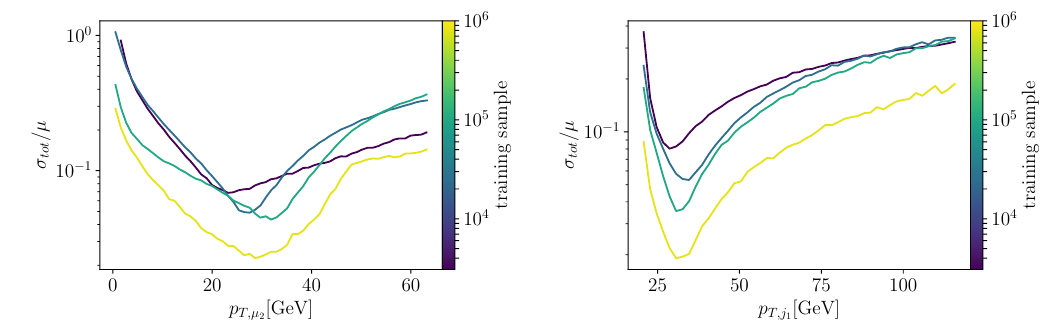
Figure 12: Relative uncertainty from the BINN for the Z + 1 jet sample, as a function of the size of the training